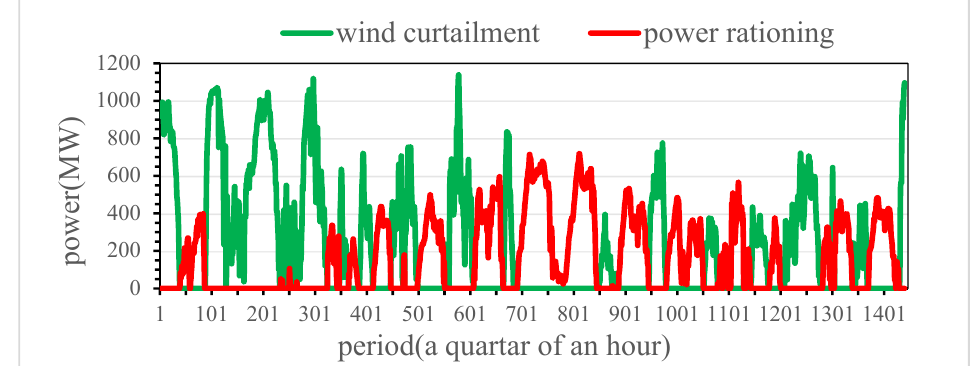
Figure 8. The situation of wind curtailment and power rationing without pumped-storage power station during peak period of heating.